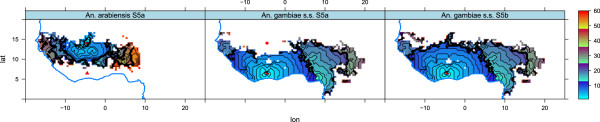
Number of months required to reach a density of 20 mosquitoes/km2. Panel 1 (left to right) represents An. arabiensis in experiment mosqTran(a), panel 2, An. gambiae s.s. with the presence of An. arabiensis (mosqTran(a)), and panel 3, An. gambiae s.s. with no competition (mosqTran(b)). The red solid circle and triangle indicate the initial position of An. arabiensis and An. gambiae s.s., respectively.